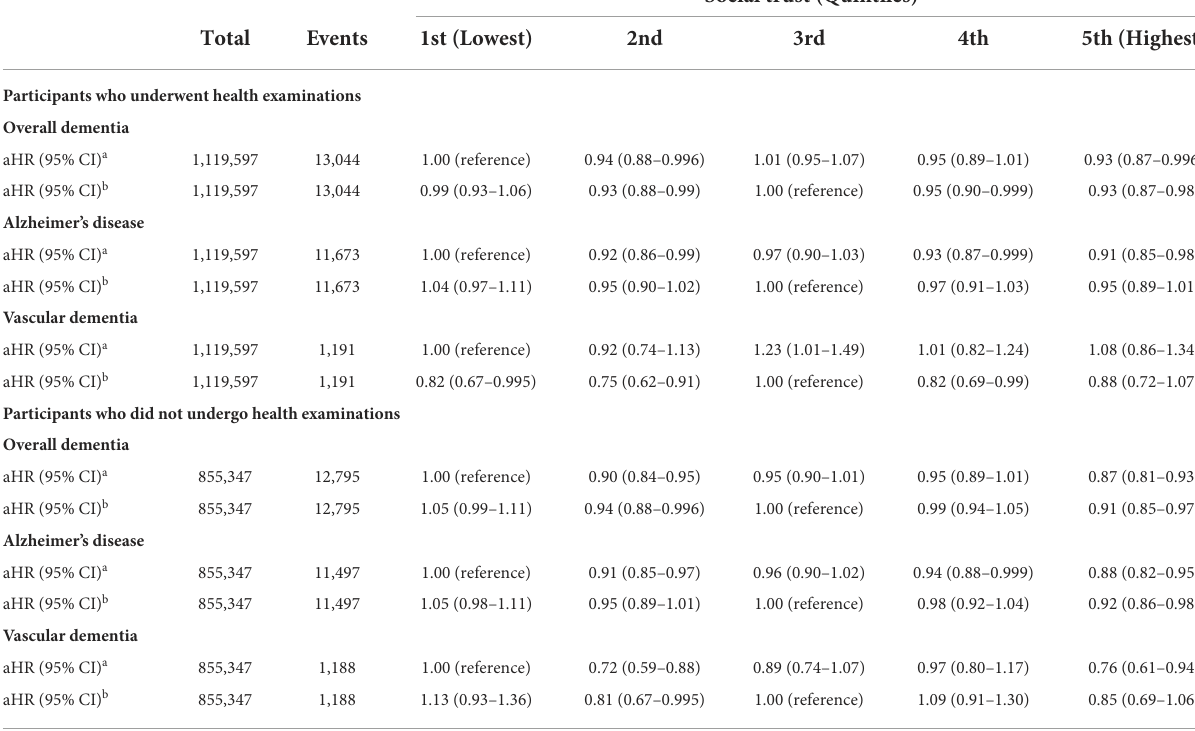
TABLE 4 Risk for dementia according to social trust considering participation in health